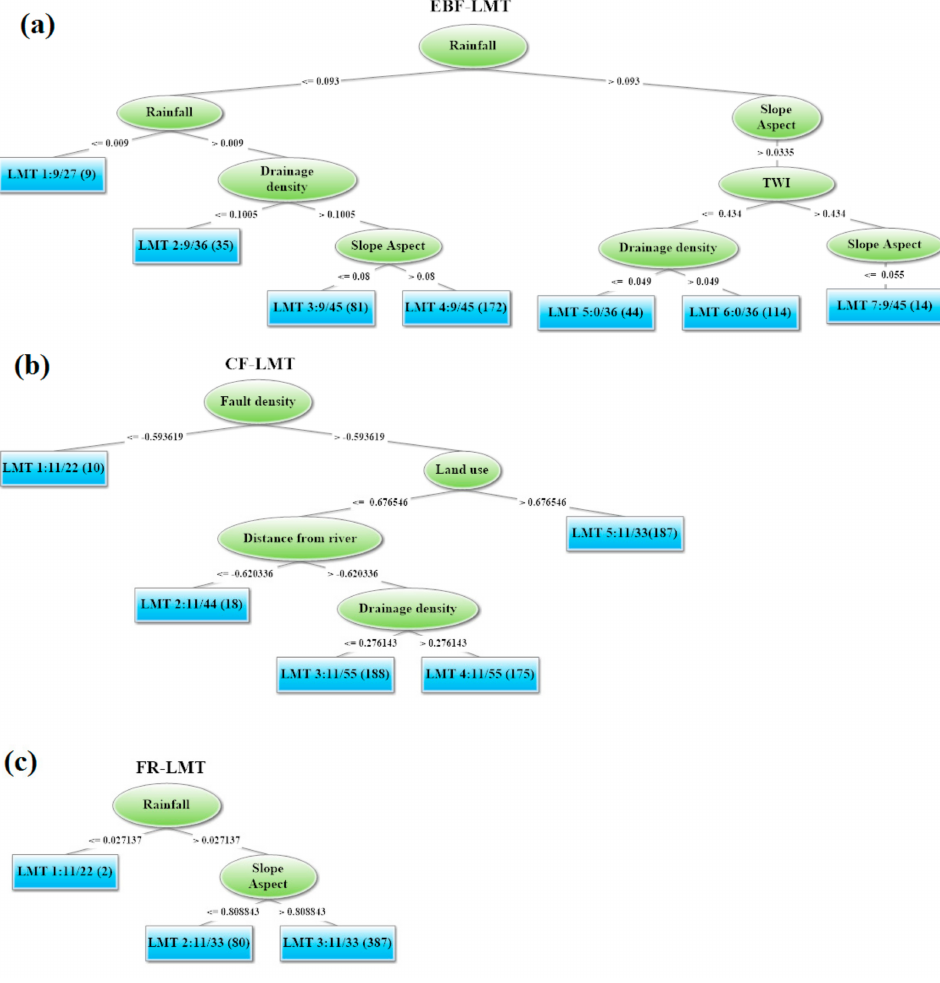
Figure 5. Result of the logistic model tree (LMT)